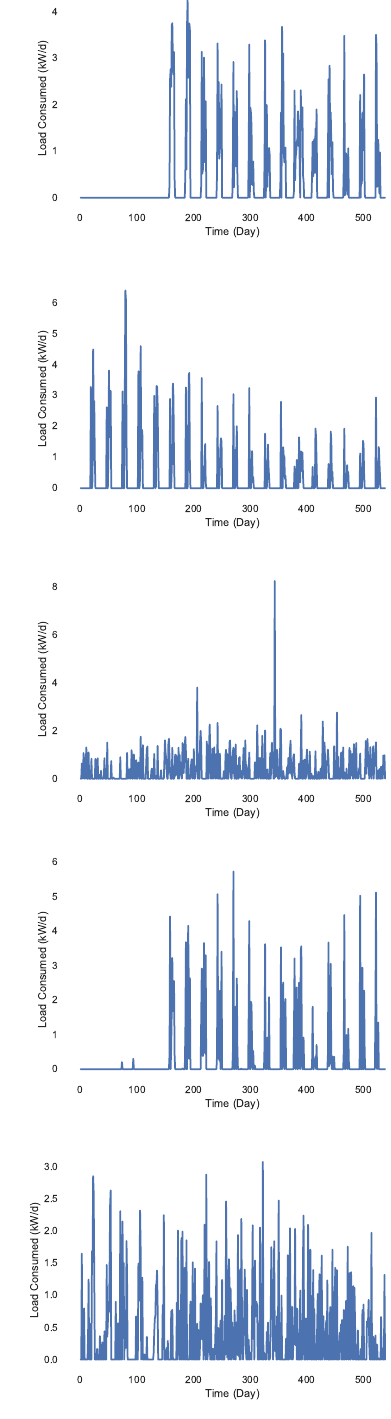
Figure 11. Daily load consumption of 10 different